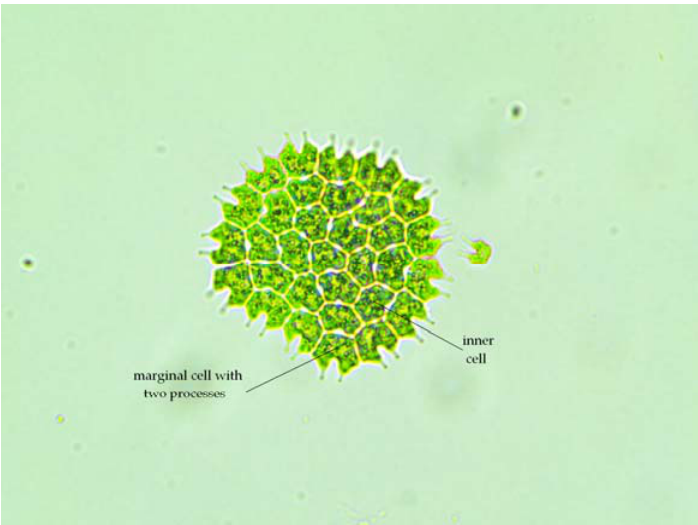
Figure 1. 32 ‐ cell coenobium of Pseudopediastrum boryanum var. longicorne under a light microscope Nikon with 400× magnification.